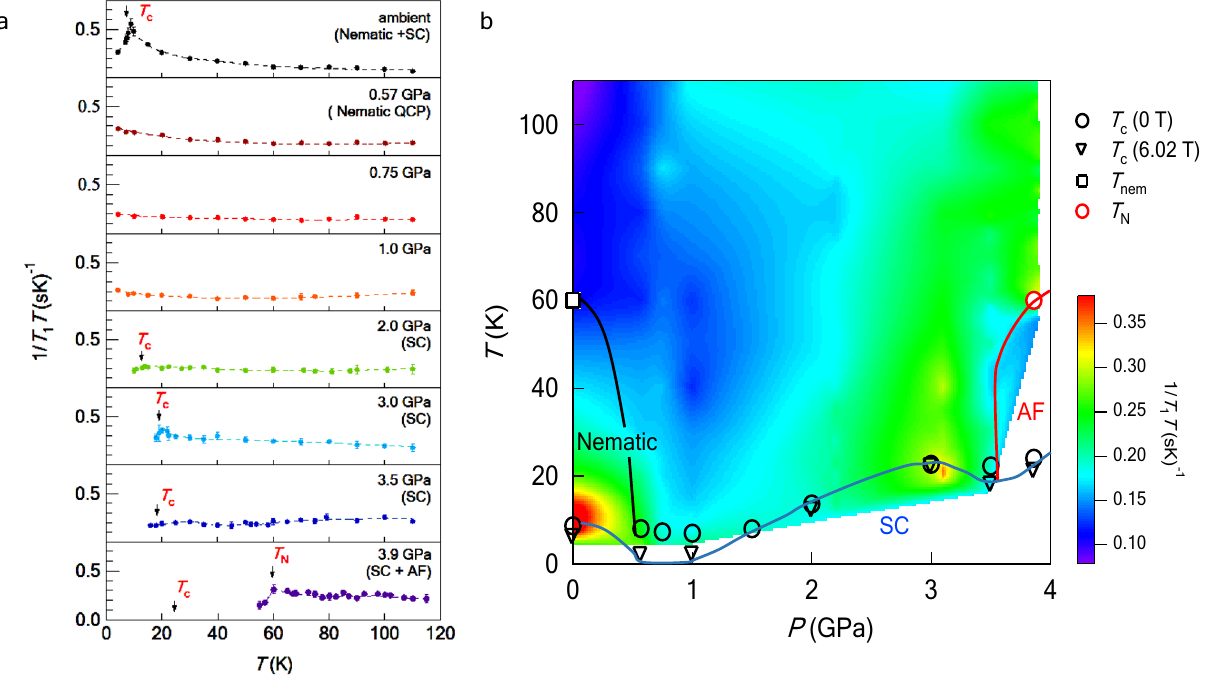
Figure 4. T dependence of 1 / T 1 T of 77 Se measured at 6.02 T and color plot of 1 / T 1 T . ( a ) The data at ambient pressure, 1.0, 2.0, and 3.0 GPa were published in an eraly work 20 . T C s shown by arrows are determined from AC susceptibility measurements at 6.02 T. Both nematic and superconducting (SC) orders are absent at 1.0 GPa. ( b ) The SC phase shows a double-dome structure at 6.02 T. T C s shown by circles and inverted triangles are determined from AC susceptibility measurements at 0 T and 6.02 T, respectively. T C s shown by inverted triangles are the same as those shown by arrows in ( a